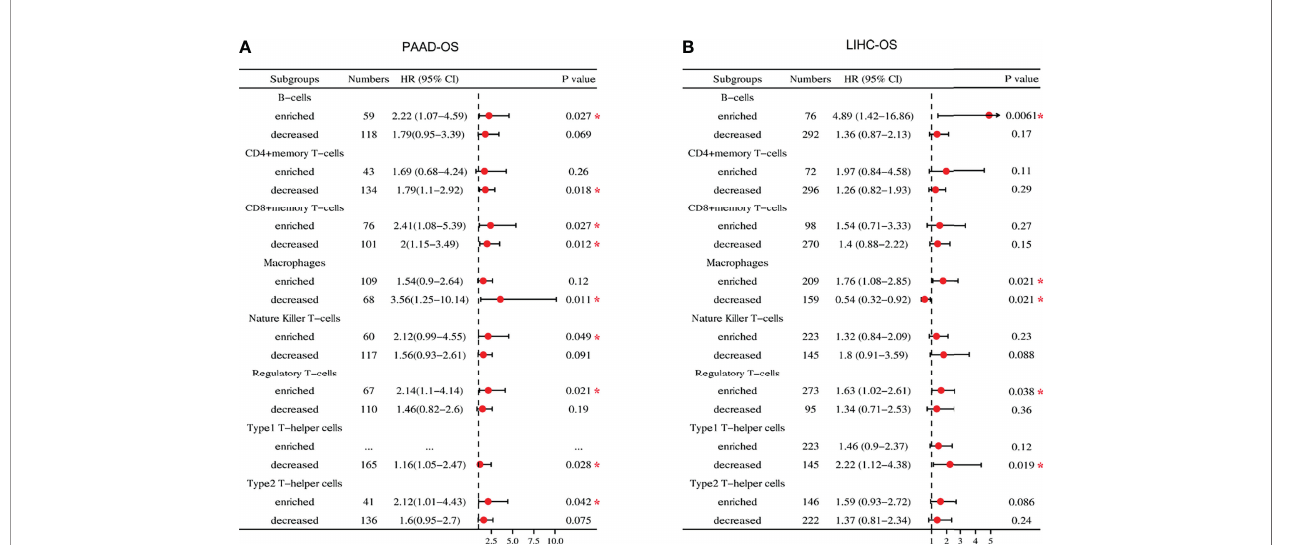
FIGURE 10 | Forest plot of the prognostic value of the expression of USP10 in immune cell subpopulations of patients with PAAD and LIHC. (A) In patients with PAAD, the prognostic bene fi t of USP10 expression depends on the patients ’ different immune cell subsets, according to the forest plot. (B) In patients with LIHC, there was an association between the expression of USP10 and OS for the in fi ltration of different immune cell subgroups, according to a forest plot. PAAD, pancreatic adenocarcinoma; LIHC, liver hepatocellular carcinoma. OS, overall survival. * P <